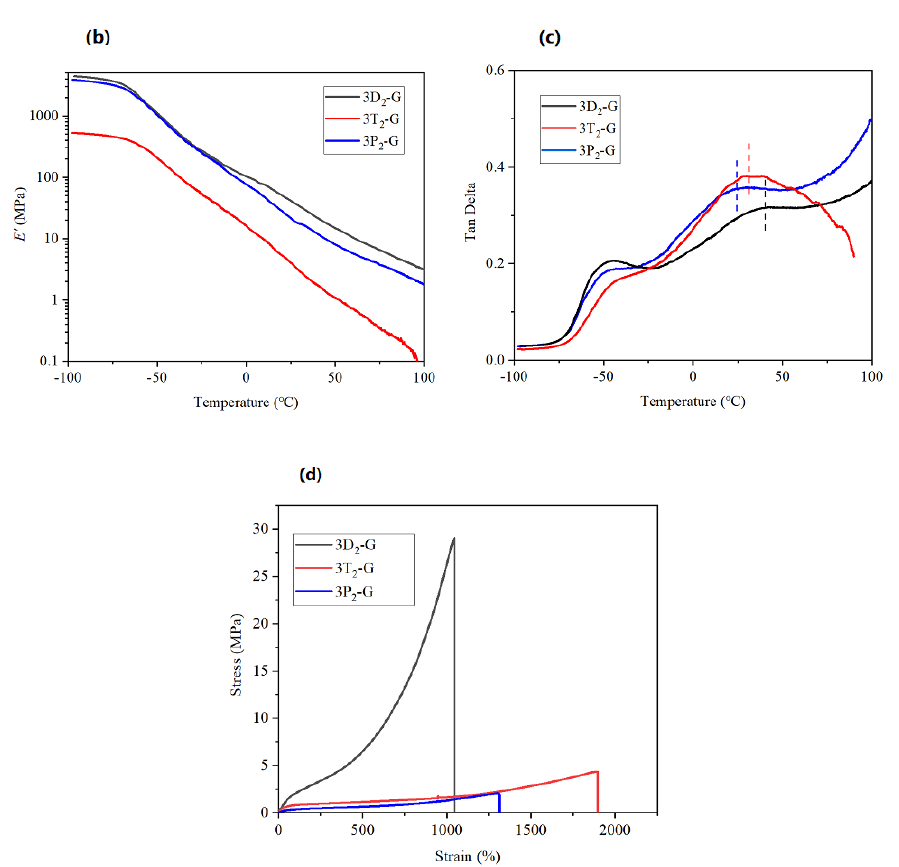
Figure 3. The comparison of 3D 2 -G, 3T 2 -G, and 3P 2 -G. ( a ) FTIR spectral peak fit in the carbonyl region (1800 to 1600 cm − 1 ). ( b ) DMA spectra of storage modulus ( E’ ) vs. temperature. ( c ) DMA spectra of tan δ vs. temperature. ( d ) Tensile stress–strain curve.